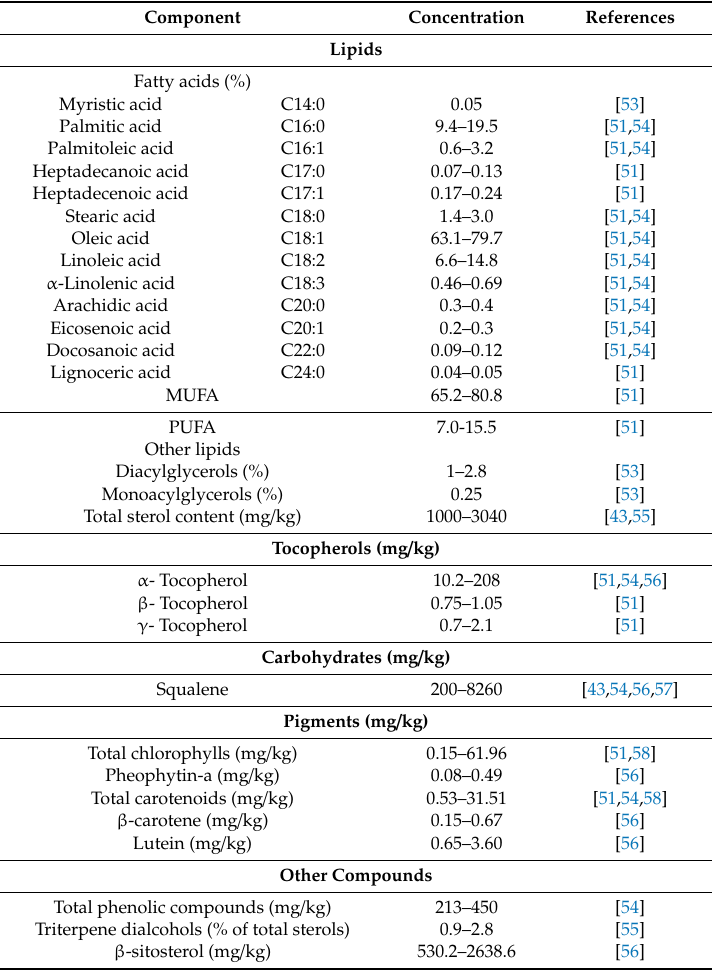
Table 2. Major EVOO